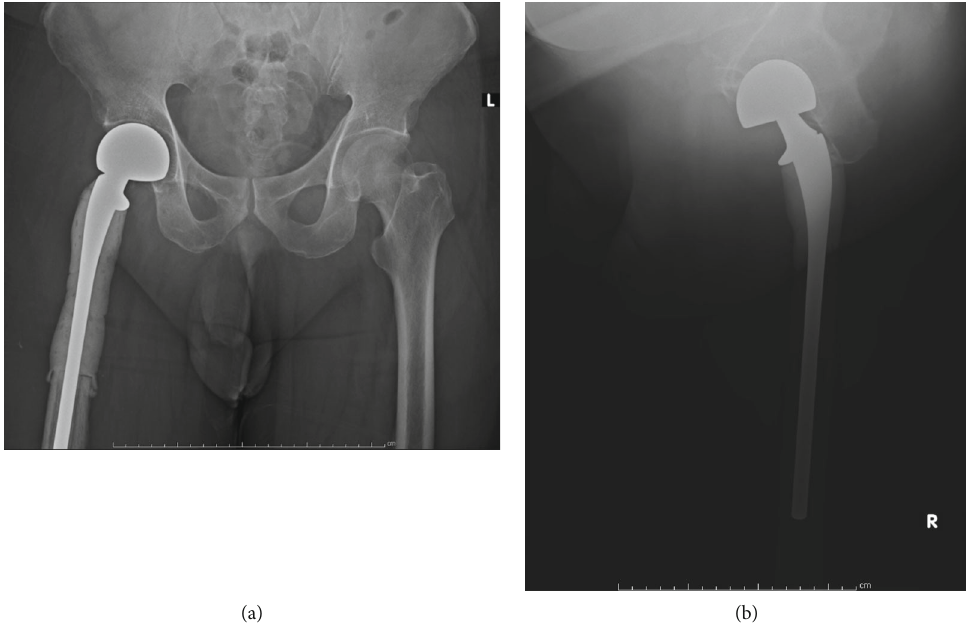
Figure 5: Postoperative radiographs after en bloc resection and reconstruction of the proximal femur: anteroposterior view (a) and trans inguinal view